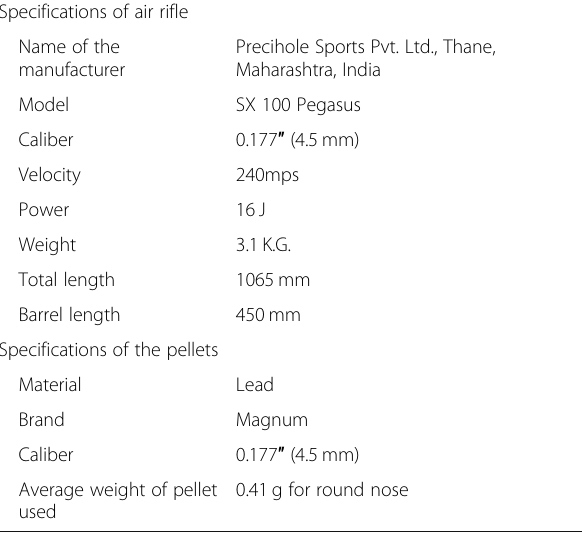
Table 1 Specification about the air rifle and pellet